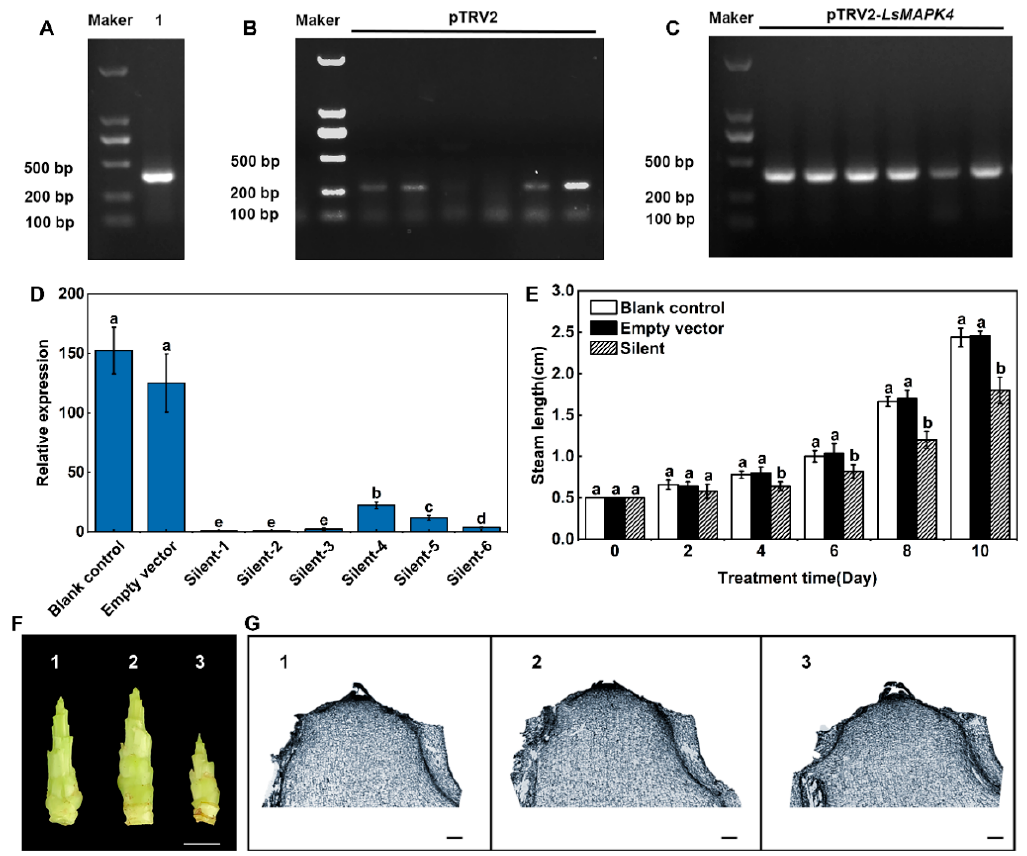
Figure 10. Effect of VIGS-mediated LsMAPK4 gene silencing on high-temperature bolting of lettuce. ( A ) Construction of the pTRV2- LsMAPK4 vector. ( B ) Detection of pTRV2 fragments. ( C ) Detection of pTRV2- LsMAPK4 fragments. ( D ) Expression of LsMAPK4 in the blank control group, the empty vector group, and the silenced group. ( E ) Changes in stem length of VIGS-infected plants after HT treatment. ( F ) Morphology of the stem on the 8th day after HT. Bar = 0.5 cm. ( G ) Morphology of the shoot tip on the 8th day of HT. Bar = 200 µm. 1. the blank control group; 2. the empty vector group; 3. the silent group. The standard error is indicated. Different letters represent significant differences as determined using one-way ANOVA followed by Duncan’s test. p < 0.05.